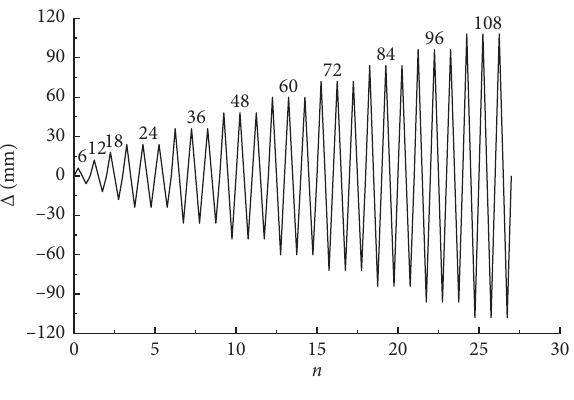
Figure 4: Loading history.